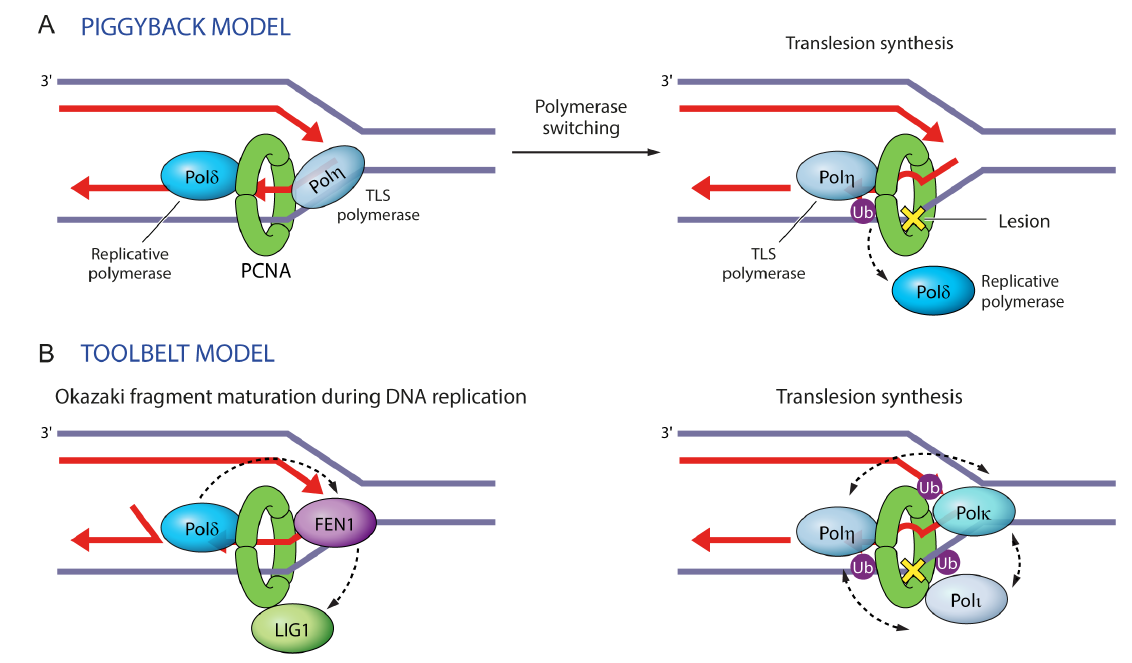
Figure 6. Two models illustrating protein maneuvers on PCNA rings. ( A ) In the ‘piggyback model’ a replicative polymerase binds to the front face of PCNA in the direction of DNA replication, whereas a TLS polymerase rides piggyback. Upon DNA damage, PCNA monoubiquitination instigates polymerase switching, whereby the replicative polymerase dissociates and is replaced by a TLS polymerase, which bypasses the lesion. ( B ) In the ‘toolbelt model’, PCNA trimers can